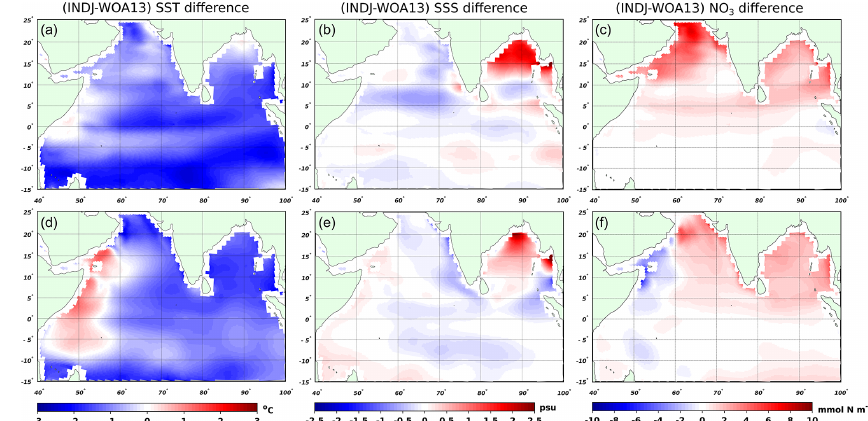
Figure 2. Spatial distribution of the difference between experiment INDJ and WOA13 for SST ( a , d ), SSS ( b , e ) and NO 3 in the surface layer ( c , f ). SST, SSS and NO 3 are time-averaged for the winter season (DJF; a – c ) and monsoon season (JJAS; d – f ) for the period 1975–2004.